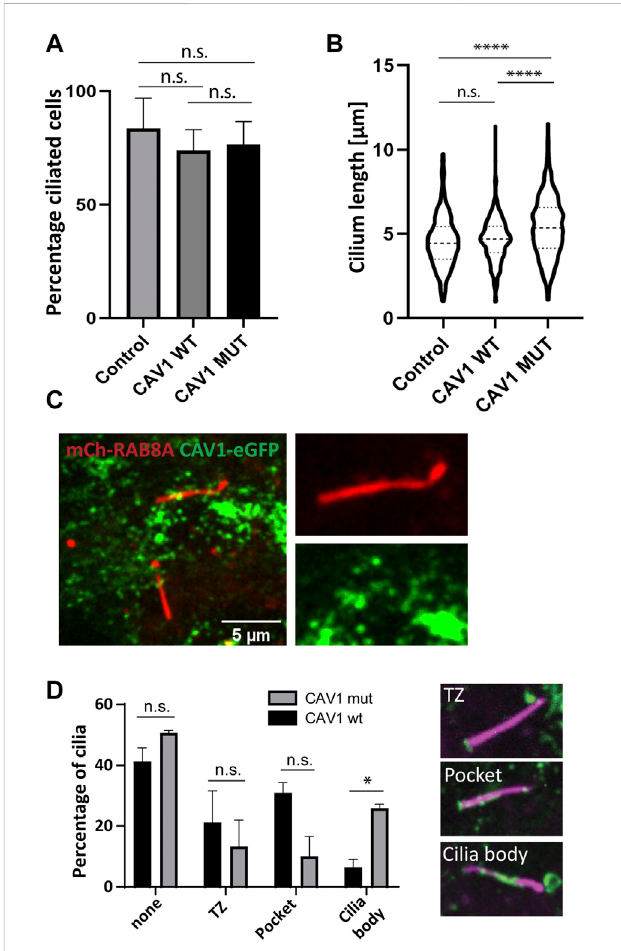
FIGURE 9 Ciliary length but not ciliation affected in CAV1 mutant lines. Three biological replicates and three technical replicates were imaged in order to determine ciliation levels and ciliary length in RPE1 Flp-In cells stably expressing eGFP-tagged CAV1 wild-type (CAV1 WT), or a CAV1ubiquitination-impairedmutant(CAV1MUT),andanuntransfected control(Control).ARL13Bwasusedas amarkerfor theciliarylength.The ALPACA tool was used to quantify both parameters. (A) The levels of ciliation between the three lines did not differ signi fi cantly. The percentage of ciliated cells was as follows: Control - 83%, CAV1 WT - 73%, and CAV1 MUT - 76%. Error bars indicate mean with SD. (B) A signi fi cant difference ( p < 0.0001) in cilia length was observed between the CAV1 MUT (cilia counted = 589), as compared to both the CAV1 WT (cilia counted = 422) and Control lines (cilia counted = 341). The latter did not differ from each other signi fi cantly. (C) A single time frame from livecellimagingofRPE1CAV1-eGFPMUTcellsstablyexpressingRAB8A- mCherry. (D) Comparison of CAV1-eGFP WT and CAV-eGFP MUT cilia localization imaged as in (C) . Total of 78 (WT) or 77 (MUT) cilia were imagedandquanti fi ed.Localizationwasclassi fi edasshown:noneforno cilia association, TZ for transition zone only localization, Pocket localization includes the transition zone and the pocket, and Body for lump-like localization on the ciliary body (as seen in C). Signi fi cance based on p <